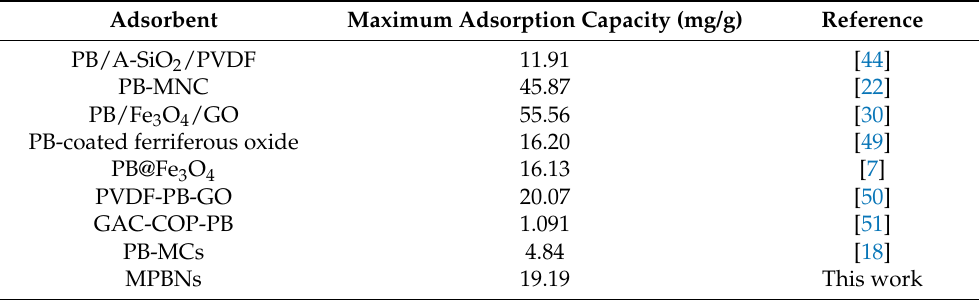
Table 3. Comparison of sorption capacities of cesium ions on MPBNs and others.